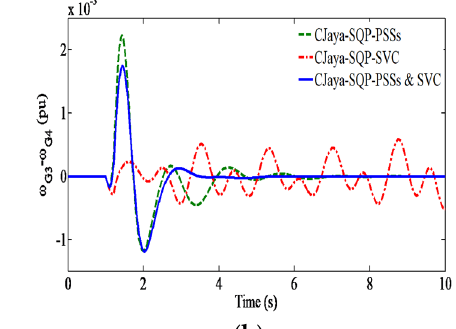
Figure 17. Power system dynamic responses for scenario I: ( a ) Speed deviation response of G1-G2;